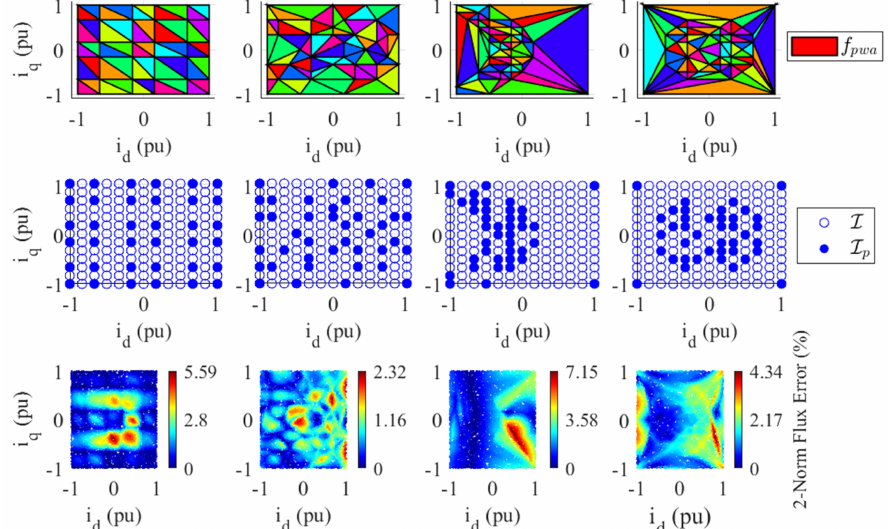
Figure 12. ( top row) Simplical mesh I M comprising all simplices I j . ( middle row) Placement of points in I P by the optimization algorithm. ( bottom row) Two-norm flux error distribution. (first column) f PWA using regularly gridded current points covering I . (second column) f PWA using irregularly gridded current points optimizing I . (third column) f PWA using irregularly gridded current points optimizing I MTPA . (fourth column) f PWA using irregularly gridded current points optimizing I derated